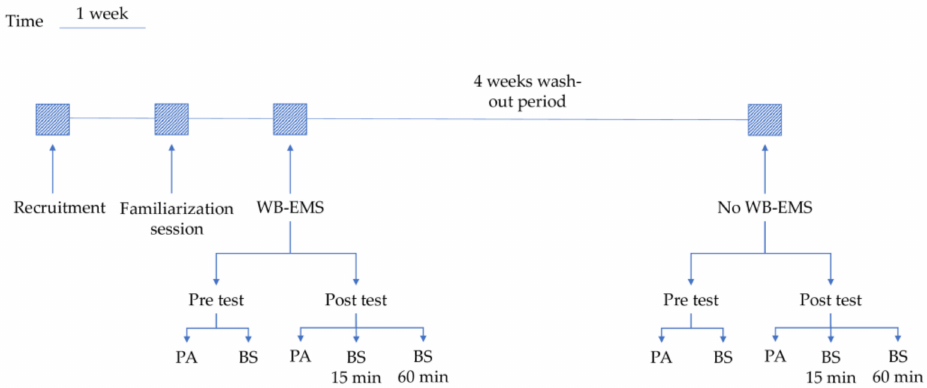
Figure 1. Diagram of experimental procedure. PA: physical assessment; BS: blood samples collection. In both WB-EMS and no WB-EMS interventions, participants underwent a 20-min workout session guided and supervised by a certified instructor. The workout session consisted of the following 5 voluntary strength exercises: half squat, full squat, bent over, core rotation and crunch (Figure 2). After 5 min of warm up, each exercise was performed for 3 min, during which participants were required to perform alternatively 4 s of isometric contraction and 4 s of static rest.